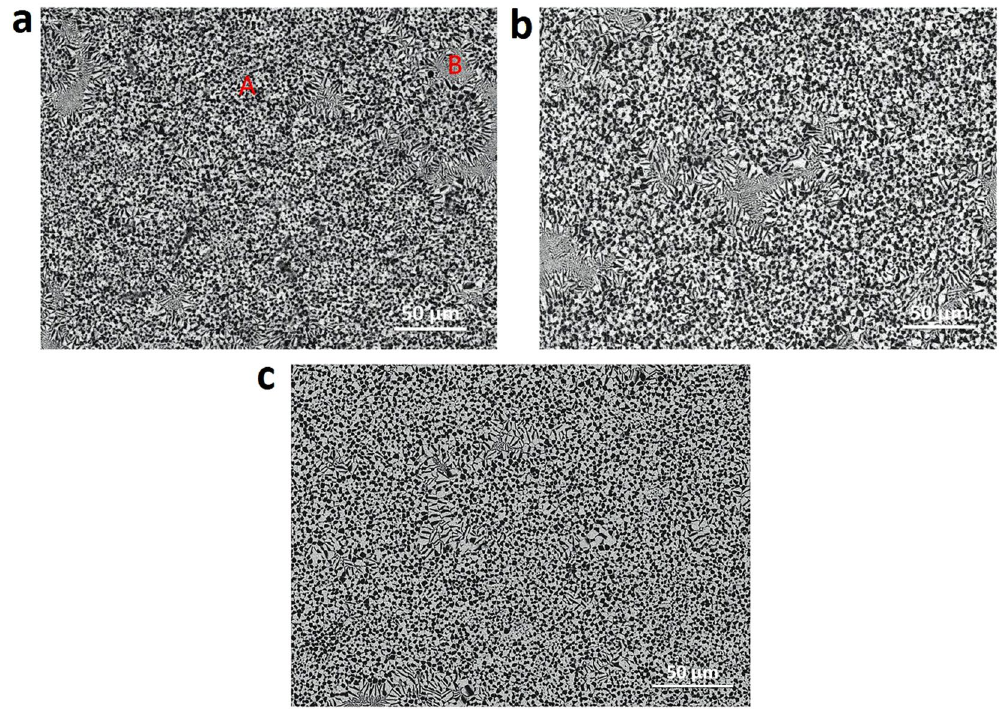
Figure 9. Microstructure of Co 76 Sn 24 alloy solidified in homogeneous magnetic field ( a ) Δ T = 236 K, B = 0 T, ( b ) Δ T = 240 K, B = 12 T, and ( c ) in 93 T/m gradient field at the undercooling of 232